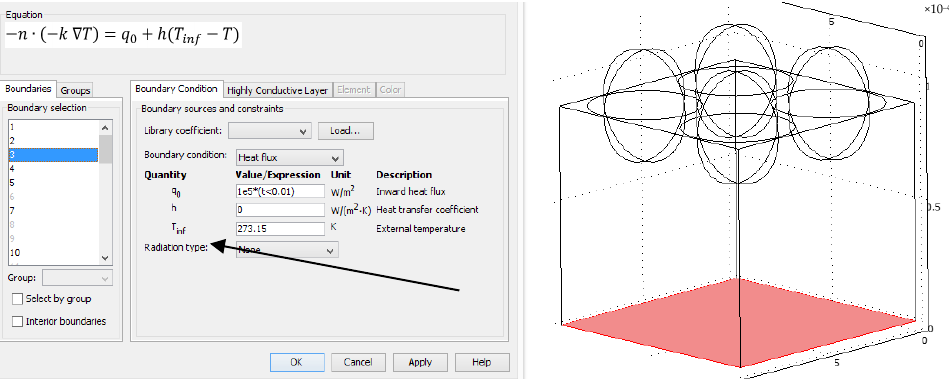
Figure 4. Setting the boundary conditions for an exemplary geometric model with 4 hemispheres. Computational grid settings. A calculation grid with tetrahedral elements was used (Figure 5).